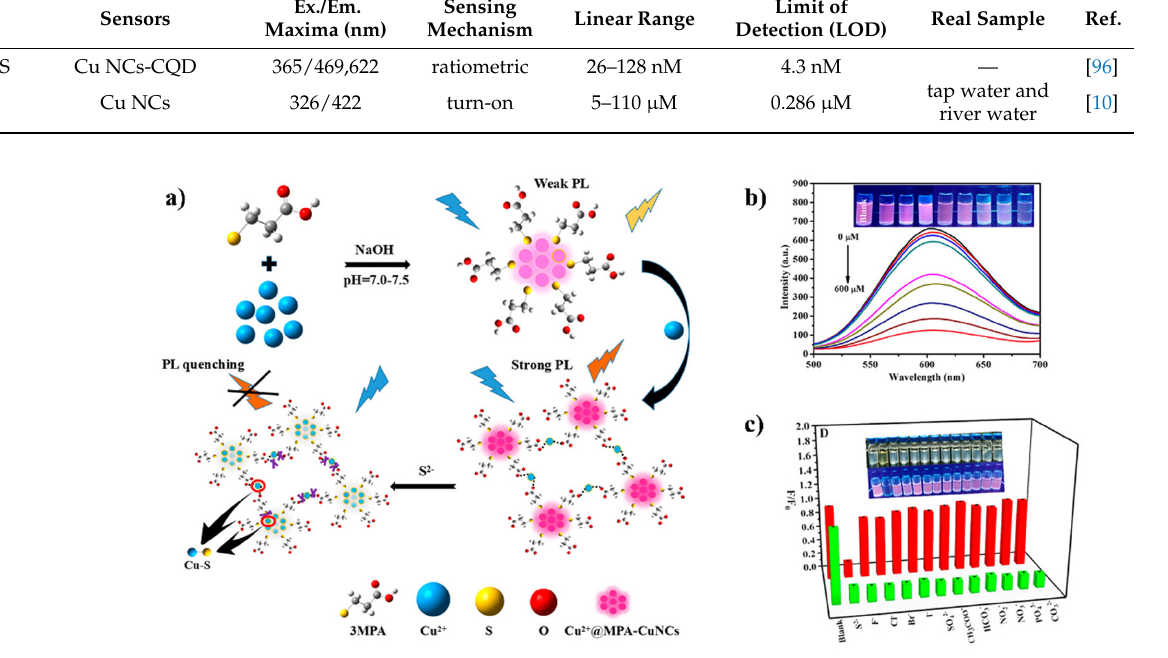
Figure 6. ( a ) Schematic illustration of the preparation of MPA-Capped Cu NCs and the aggregation induced PL weakening of Cu 2+ @MPA-Cu NCs in the presence of S 2 − ; ( b ) fluorescence emission spectra of Cu 2+ @MPA-Cu NCs in the presence of various concentrations of S 2 − in Tris-HCl buffer solution; ( c ) effect of different anions on the fluorescence intensity of Cu 2+ @MPA-Cu NCs (red pillars), and the influence on the sensor in the presence of different anions coexisting with S 2 − ions (green pillars).